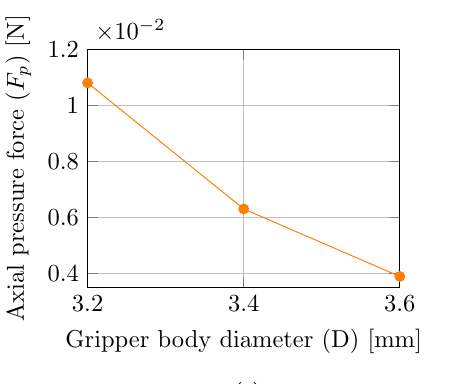
annulus area reduces shear stress on the lateral surface, and consequentially, viscous force ( F V ) acting on the releasing mass wall decreases.